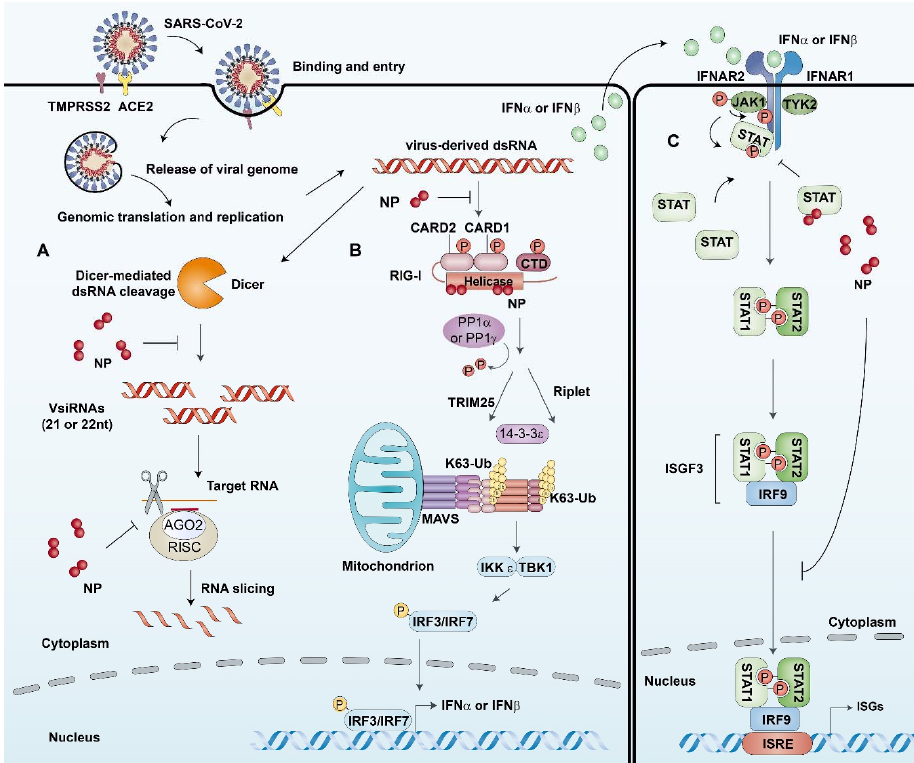
Figure 2. The host cell’s innate immune processes involving the N protein. ( A ) N proteins act as viral suppressors of RNA interference (RNAi) in host cells. In the initiation step, the dsRNA in infected cells could be sequestrated by N proteins, which prevent the recognition and cleavage of viral dsRNA by Dicer. In addition, the N protein can suppress siRNA-induced RNA degradation in the effector step. ( B ) N proteins interact with RIG-I and repress RIG-mediated IFN- β production. N proteins can interact with RIG-I through the helicase domain of DExD/H-box helicases, which has ATPase activity and plays an important role in the binding of immunostimulatory RNAs. Therefore, SARS-CoV-2 N proteins suppress the IFN- β response by targeting the initial step of IFN activation. ( C ) N proteins antagonize type I IFN signaling by suppressing phosphorylation and nuclear translocation of signal transducer and activator of transcription 1 and 2 (STAT1 and STAT2). The binding of secreted type I IFN to their receptors on neighboring cells can trigger phosphorylation of pre-associated Janus kinase 1 (JAK1) and tyrosine kinase 2 (TYK2), which in turn phosphorylates the receptors. This leads to the recruitment and phosphorylation of STAT1 and 2. In SARS-CoV-2 infected cells, N proteins can interfere with the interactions of STAT1 with JAK1 and STAT2 with TYK2 by competitively binding to STAT1/STAT2 and in turn inhibit their phosphorylation. Therefore, N proteins further reduce the subsequent nuclear translocation of the IFN-stimulated gene factor 3 (ISGF3) transcription complex and inhibiting the expression of IFN stimulated genes ( ISGs).